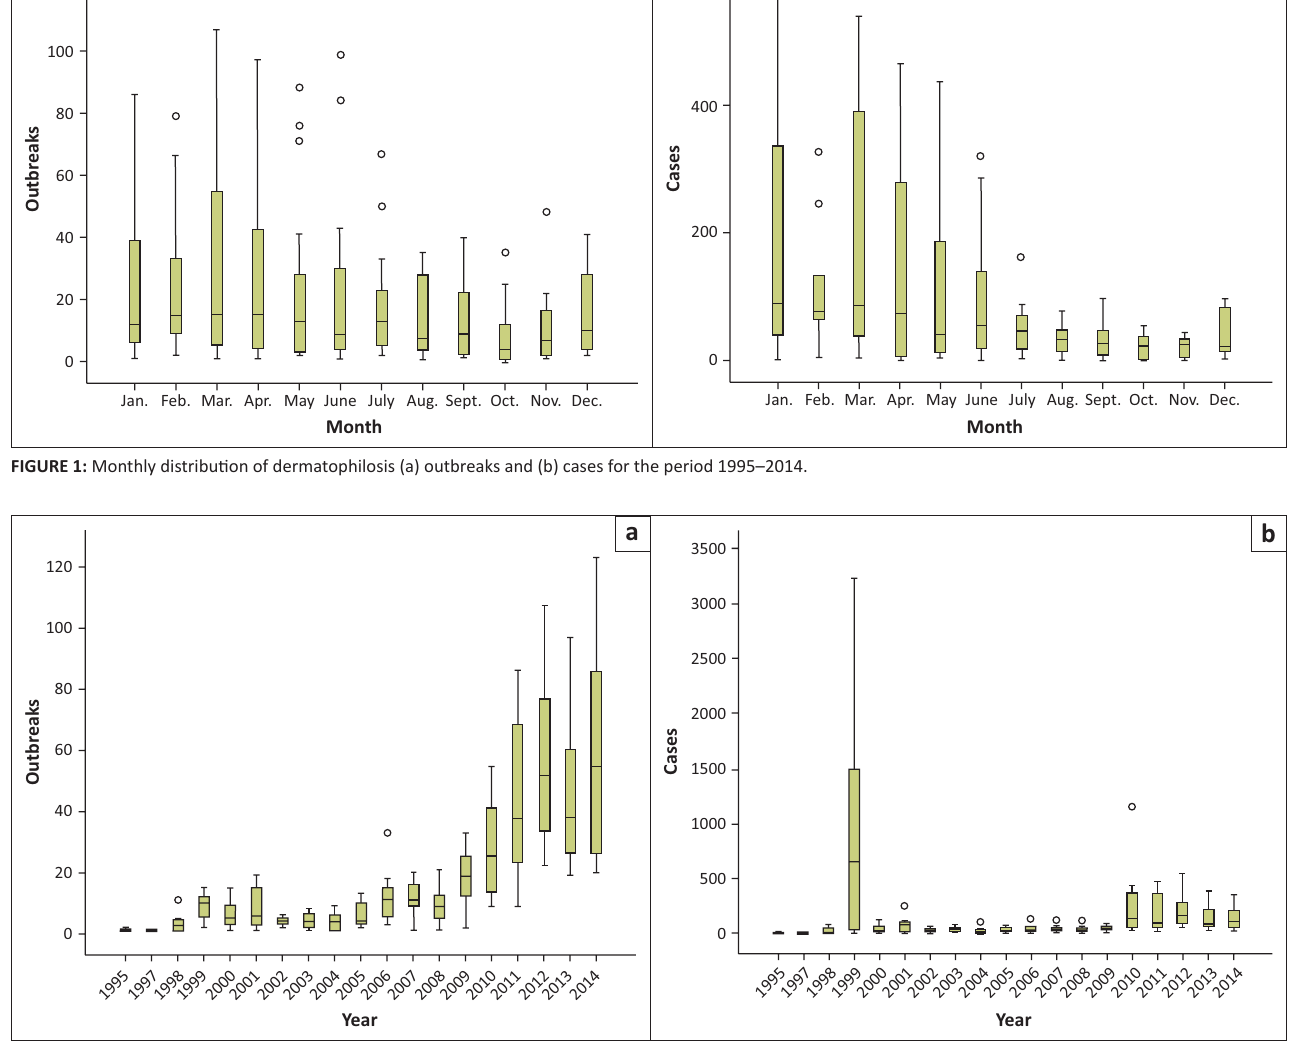
FIGURE 2: Annual distribution of dermatophilosis (a) outbreaks and (b) cases for the period